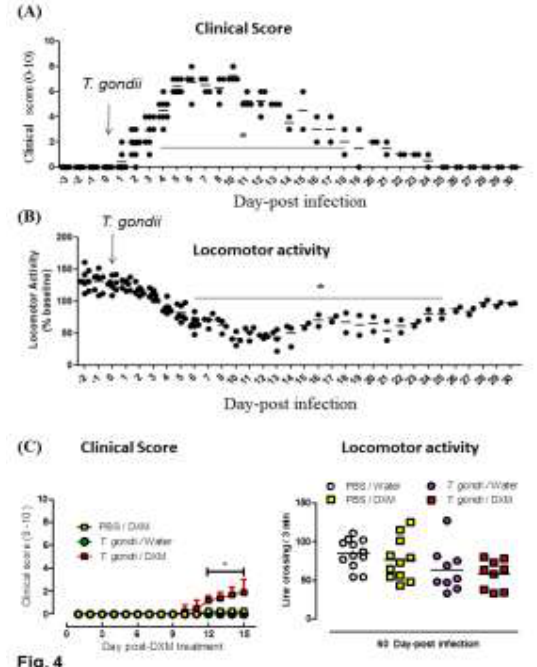
Fig. 4: Examination of clinical scores and locomotor activity in T. gondii - infected mice during acute chronic and reactivation stages. Clinical score (A) and locomotor activity (B) were measured once a day for 30 days. (C) In addition, clinical score was also measured for 3 days before and for 14 days during treatment with DXM. (D) Similarly, locomotor activity was measured at 60 dpi ( n =12). Data represent mean ±